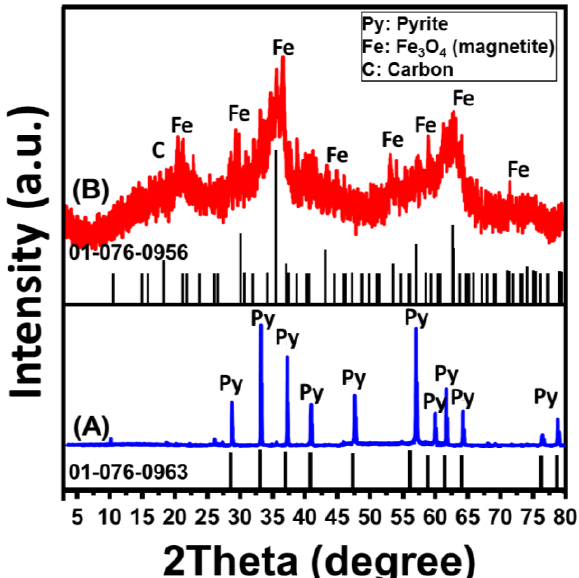
Figure 1. XRD pattern of the used raw pyrite ( A ) and the synthetic MG/CFC green nanocomposite ( B